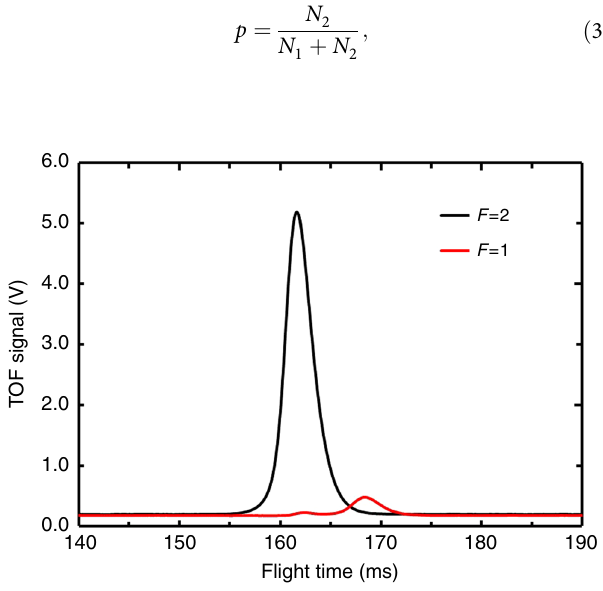
Fig. 2 Typical time-of- fl ight (TOF) signal. Flight time begins when the cold atomic cloud is launched. The red and black curves correspond to the fl uorescence from states F ¼ 1 ; m